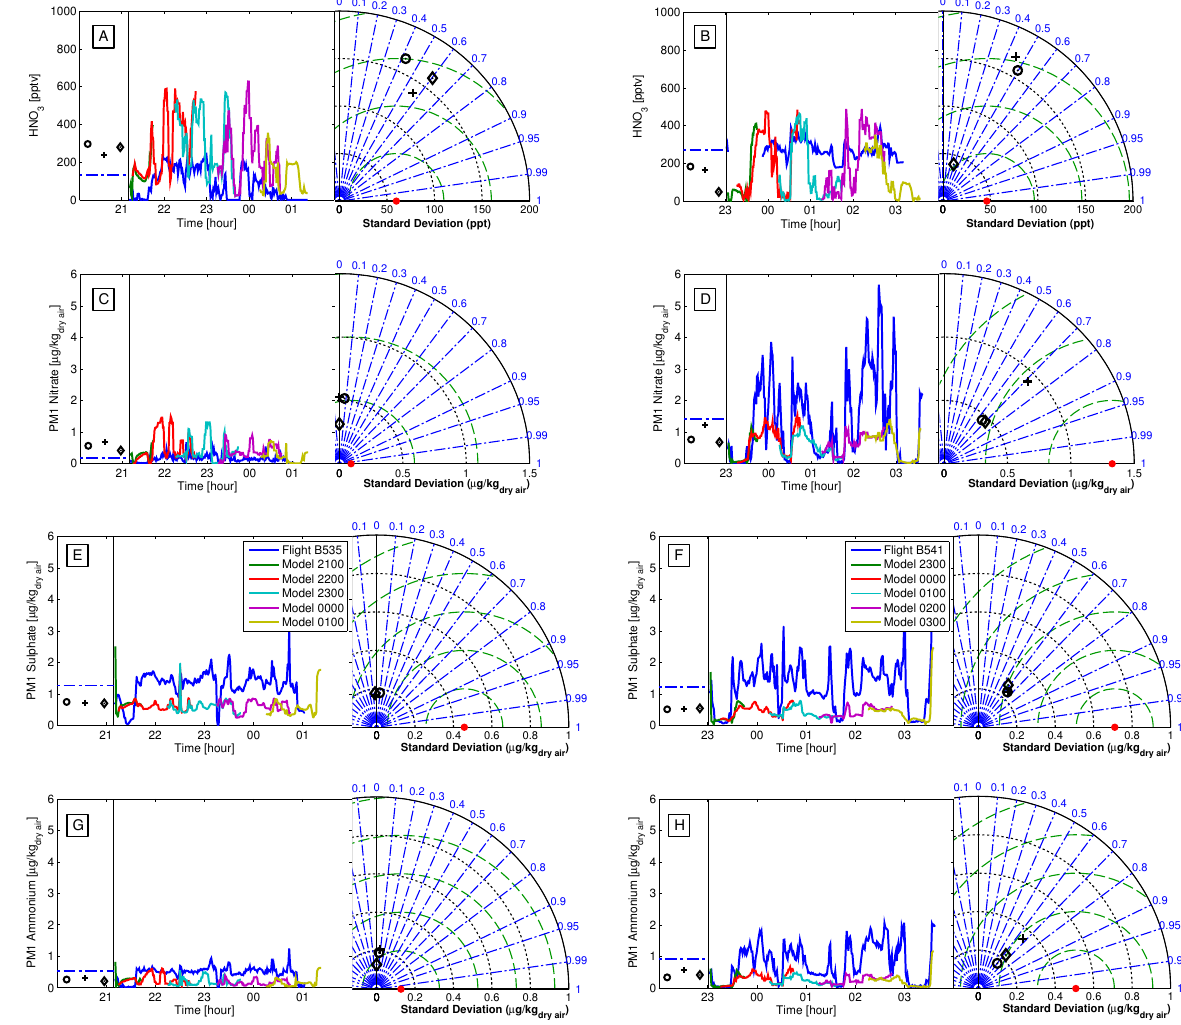
Figure 9. Flight track measurement–model comparisons and statistics for gas-phase HNO 3 and PM 1 nitrate, sulfate, and ammonium for flight B535 ( a , c , e , and g , respectively) and flight B541 ( b , d , f , and h , respectively). Symbols representing the different model scenarios are the same as those used in Fig.